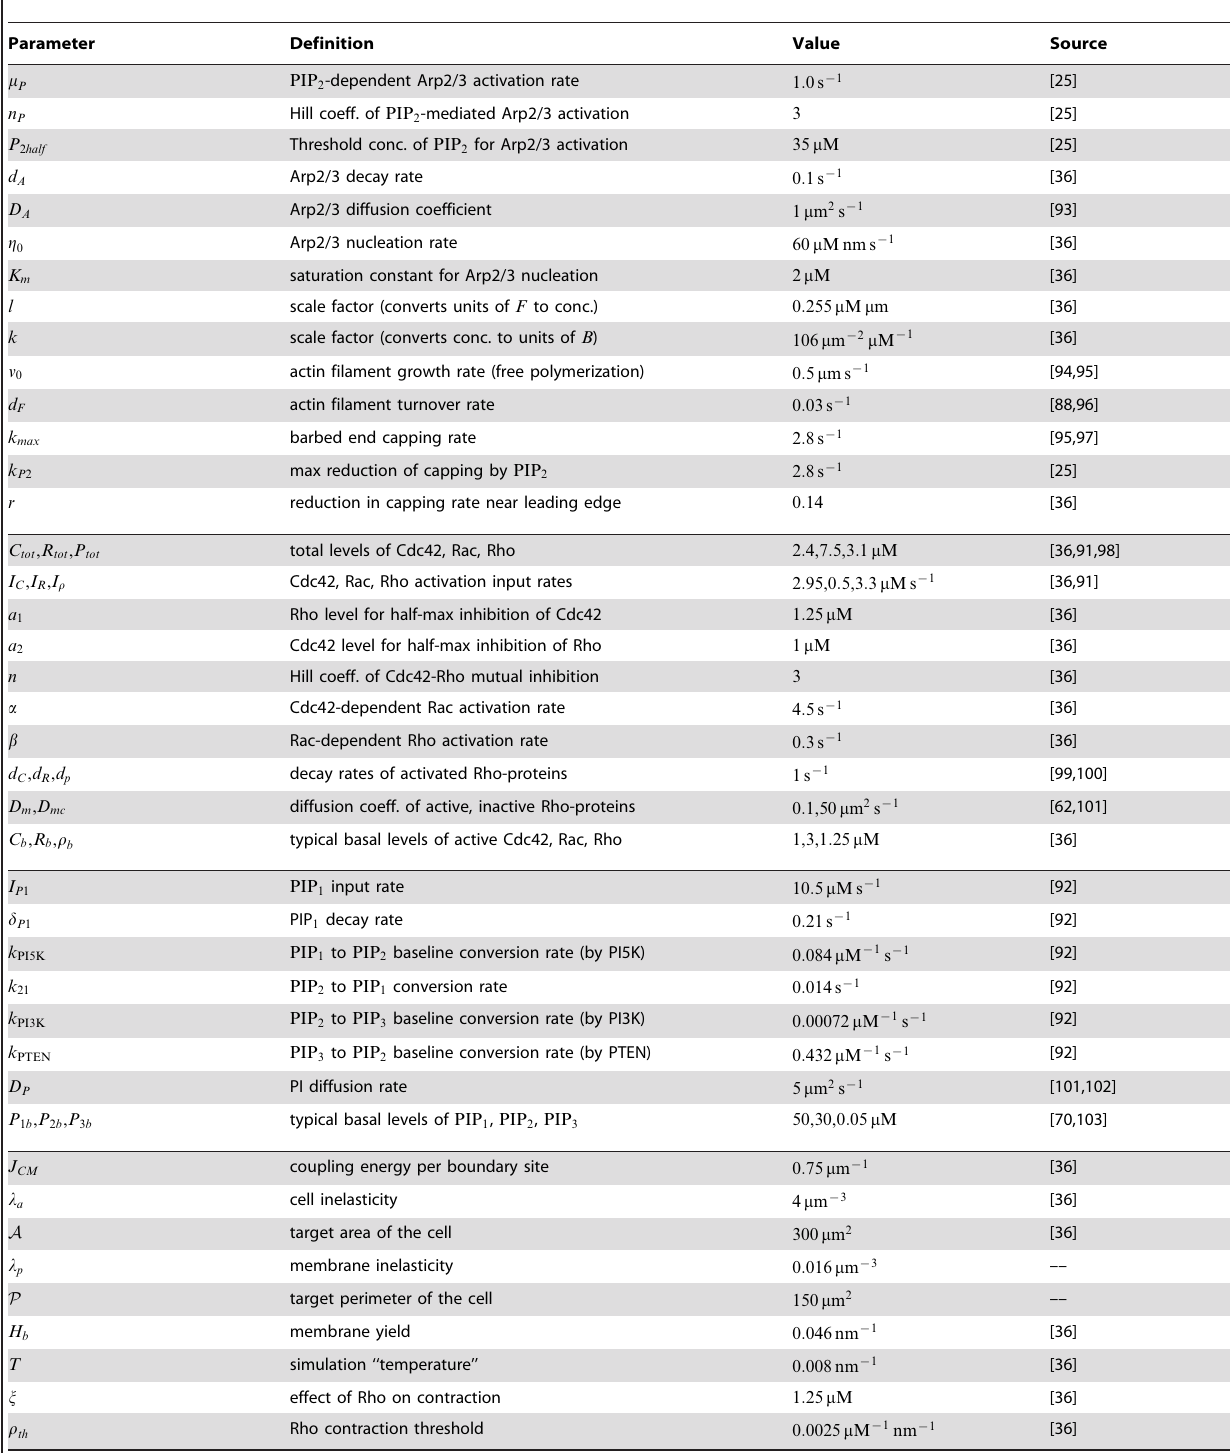
Table 1. Parameter estimates relevant to (i) actin dynamics; (ii) Rho-proteins; (iii) phosphoinositide dynamics; and (iv) cell surface mechanics, with sources from which they were